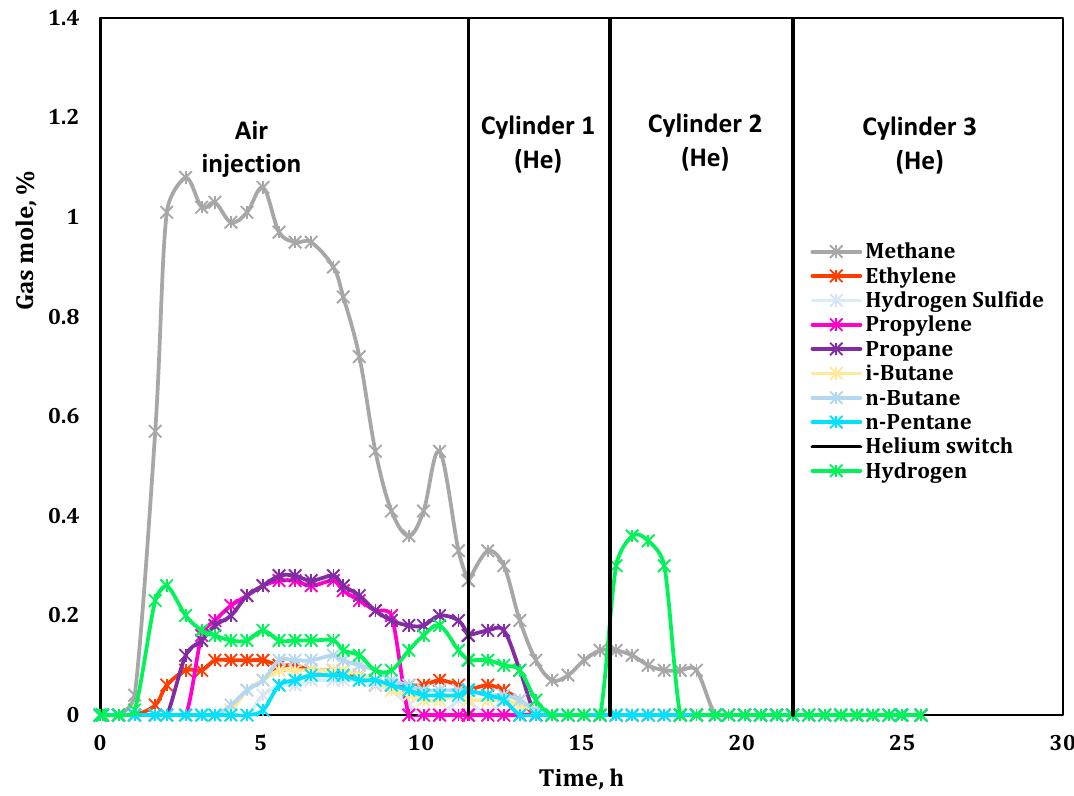
Figure 13. Produced light hydrocarbon gas composition for the vuggy test. The light hydrocarbon gases, as presented in Figure 13, were most likely products of the thermal cracking reactions and displayed a stable production during the